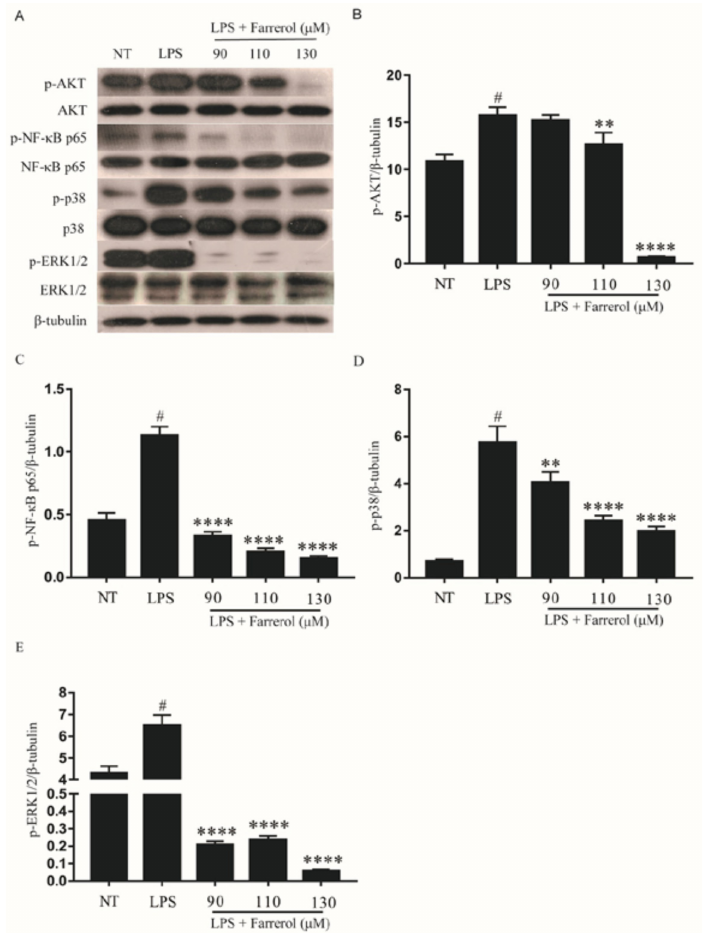
Figure 9. Farrerol inhibited the phosphorylation of AKT, NF- κ B, p38 and ERK1/2 in LPS-stimulated mMECs. The phosphorylation AKT ( A , B ); NF- κ B p65 ( A , C ); p38 ( A , D ); and ERK1/2 ( A , E ) were measured by Western blot. Data were presented as mean ± SEM ( n = 3). # p < 0.05 vs. NT group; ** p < 0.01 and **** p < 0.0,001 vs. LPS